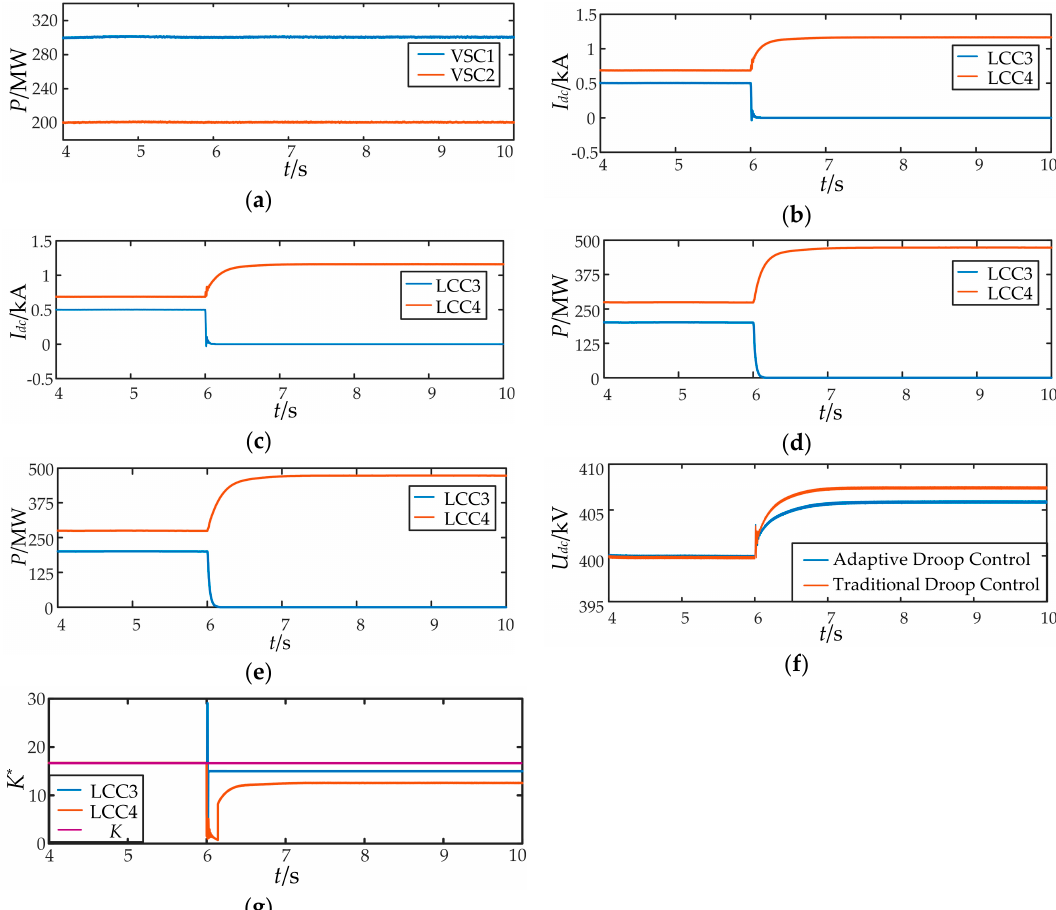
Figure 15. Simulation waveforms of LCC3 being out of operation: ( a ) Active power of VSC1 and VSC2; ( b ) DC current of LCC with adaptive droop control; ( c ) DC current of LCC with traditional droop control; ( d ) active power of LCC with adaptive droop control; ( e ) active power of LCC with traditional droop control; ( f ) DC voltage; ( g ) adaptive droop coefficient of LCC converter